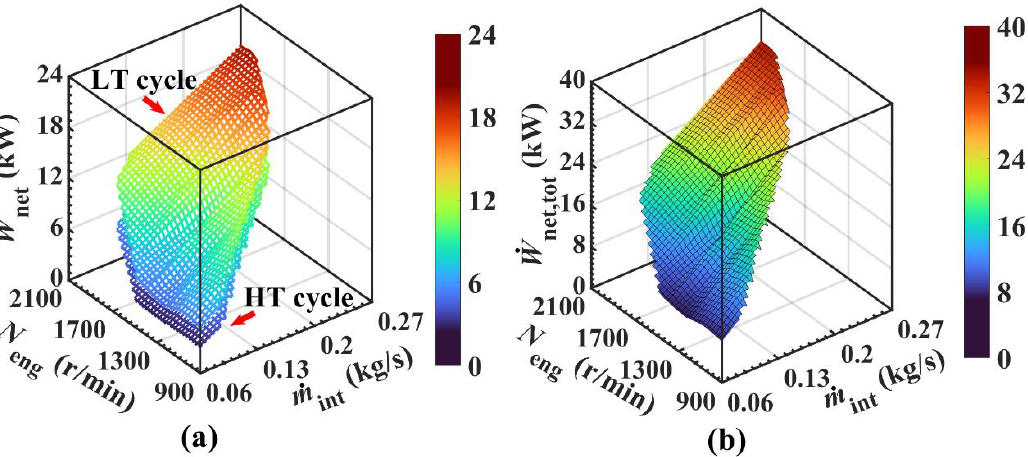
Figure 5. Power output of HT cycle, LT cycle and system in variable working environments. (a) Power characteristic. (b) power characteristic in the system.